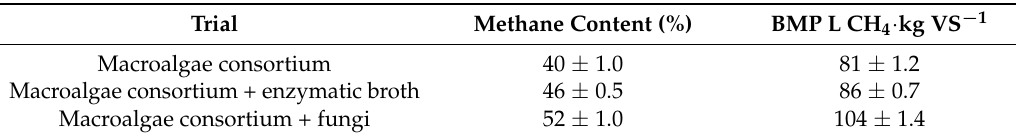
Table 2. Methane content and production for the various BMP test trials.